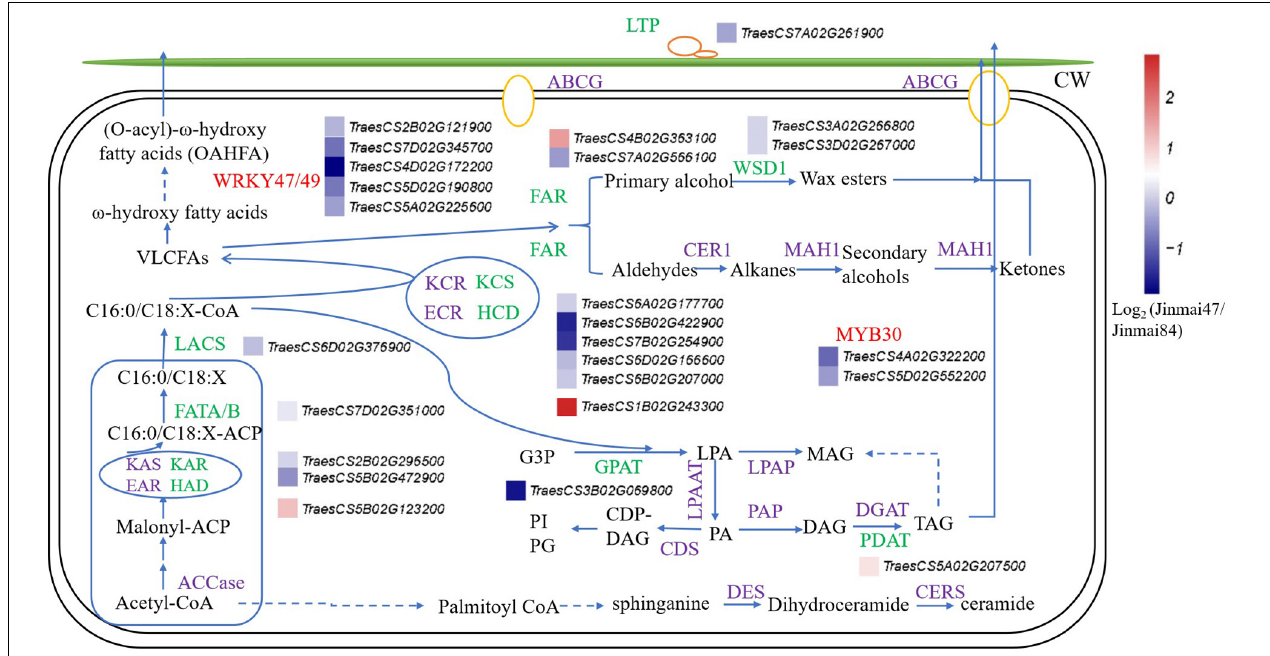
FIGURE 5 | The pathway of epicuticular wax biosynthesis in wheat. The green represents genes detected via transcriptomic analysis, purple represents genes not detected, and the red represents transcription factors. Relative expression profiles (blue-white-red intensity scale) of unigenes are shown. Red indicates upregulated expression and blue indicates downregulated expression. Log2 (Jinmai47/Jinmai84) represents the gene expression fold change, where Jinmai47/Jinmai84 refers to the ratio of FPKM reads.